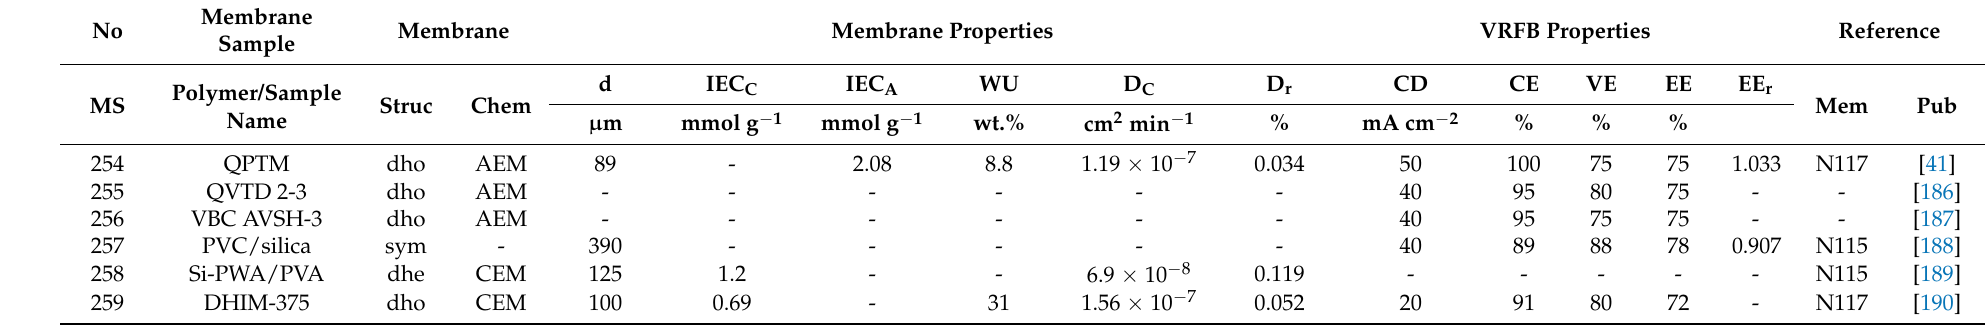
Table 11. List of other hydro-carbon-based membrane